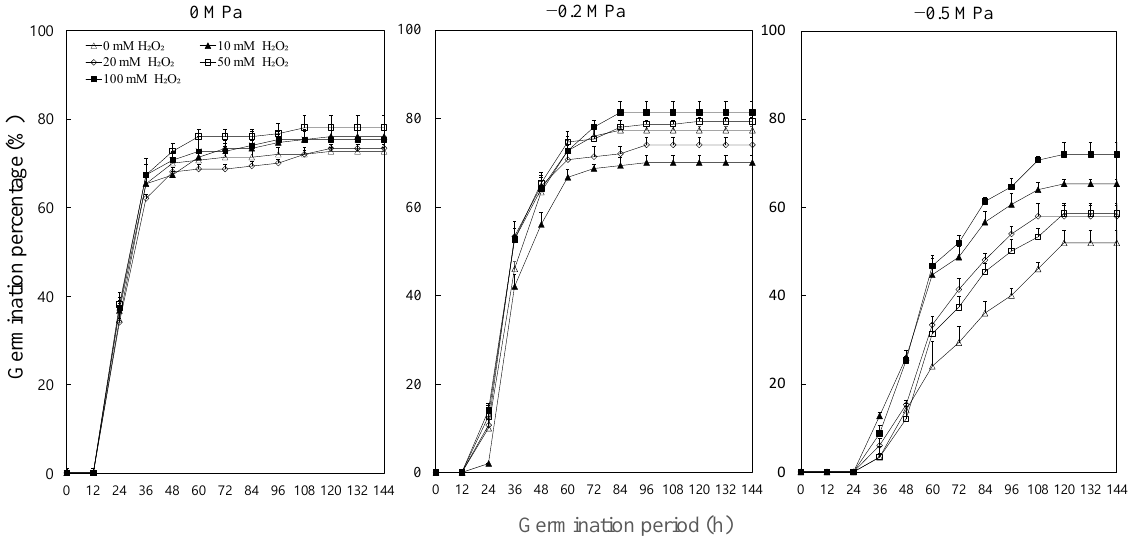
Figure 1. Effect of hydrogen peroxide on germination of sorghum seeds under different drought conditions imposed with various water potentials of 0, − 0.2, and − 0.5 MPa controlled with PEG 6000. Hydrogen peroxide was treated at the rate of 0, 10, 20, 50, and 100 mM in PEG solution. All values are the means ± SE of three replicates of 30 seeds each. The protrusion of a 2 mm radicle was used as the criterion for the completion of germination. All values are the means ± SE of four replicates of 30 seeds